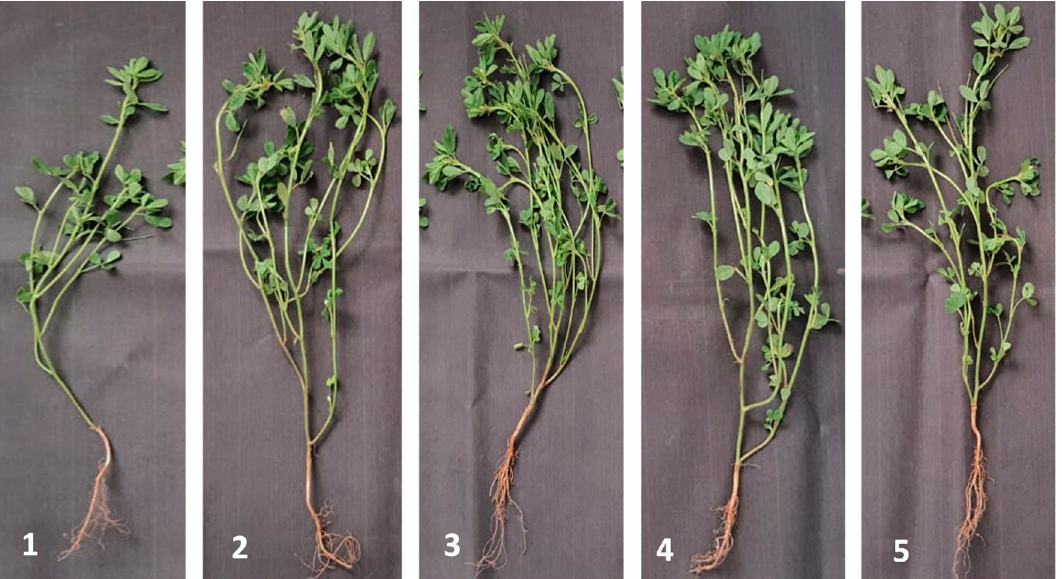
Figure 5. Fenugreek growth characteristics as affected by application of various endophyte Achro- mobacter sp. F23KW treatments under field conditions. The negative control without any treatment ( 1 ), the single application of endophytic bacterial cells ( 2 ), the single application of endophytic bacterial supernatant ( 3 ), the mixture of bacterial cells and supernatant ( 4 ), and the recommended fungicide ( 5 ).